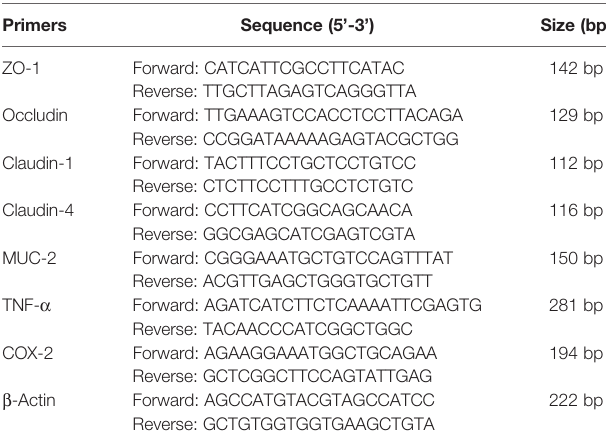
TABLE 1 | List of PCR primers and amplicon